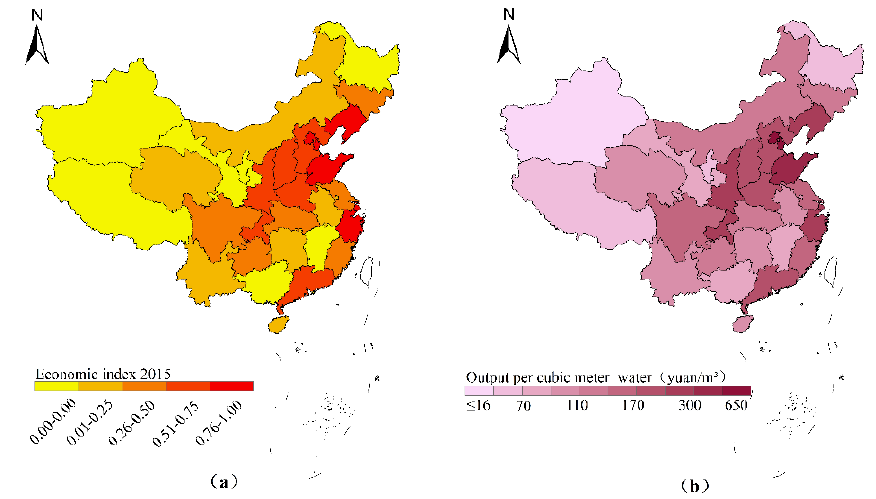
Figure 3. Spatial distribution map: ( a ) economic index, ( b ) output per cubic meter water in 2015.